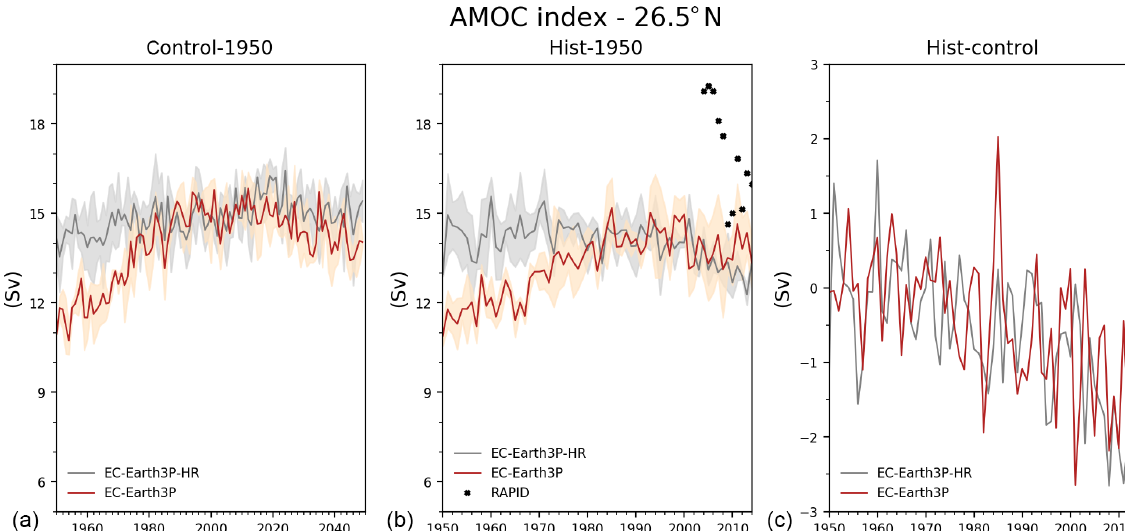
Figure 17. Time series of the annual AMOC index for the control-1950 (a) and hist-1950 (b) runs. Solid lines display the ensemble mean for the EC-Earth3P (red) and EC-Earth3P-HR (black). Shaded areas represent the dispersion due to the ensemble members. Black stars in panel (b) display values of RAPID data. (c) Mean ensemble difference between hist-1950 and control-1950 for Earth3P (red) and EC- Earth3P-HR (black).